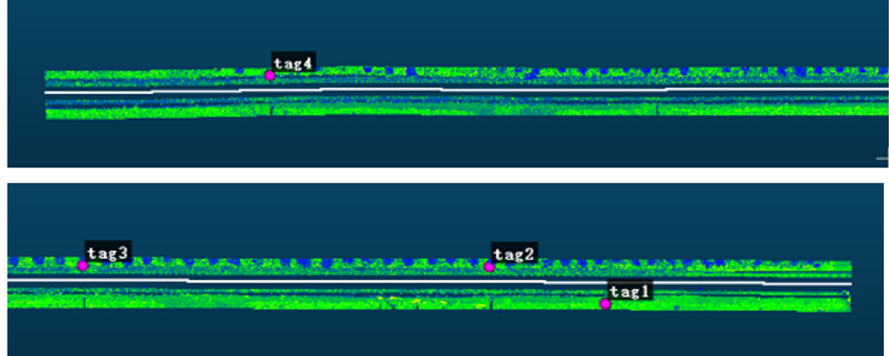
Figure 17. Point cloud generation overall effect.